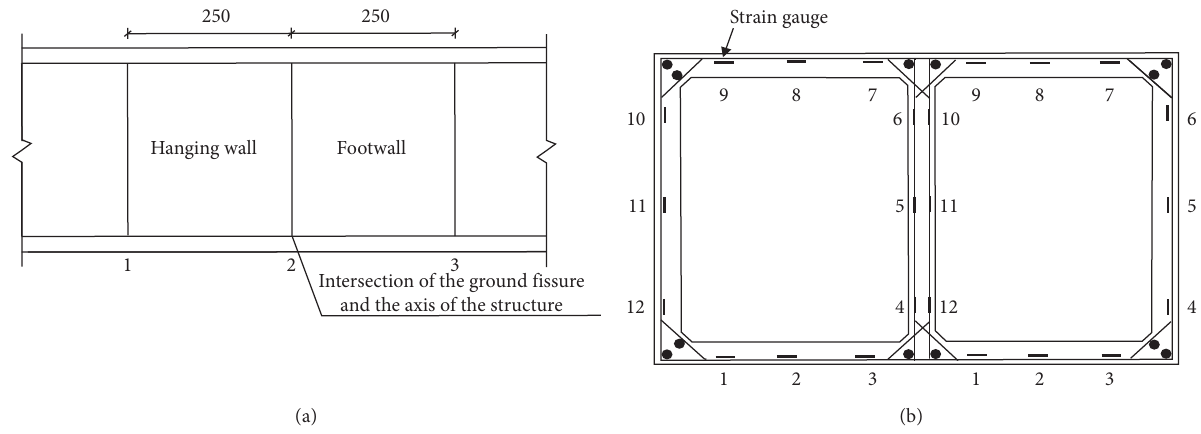
Figure 6: Reinforcement ring strain gauge layout (cm). (a) Position of strain gauges on stirrups (cm). (b) Stirrup cross-sectional strain gauge layout diagram.